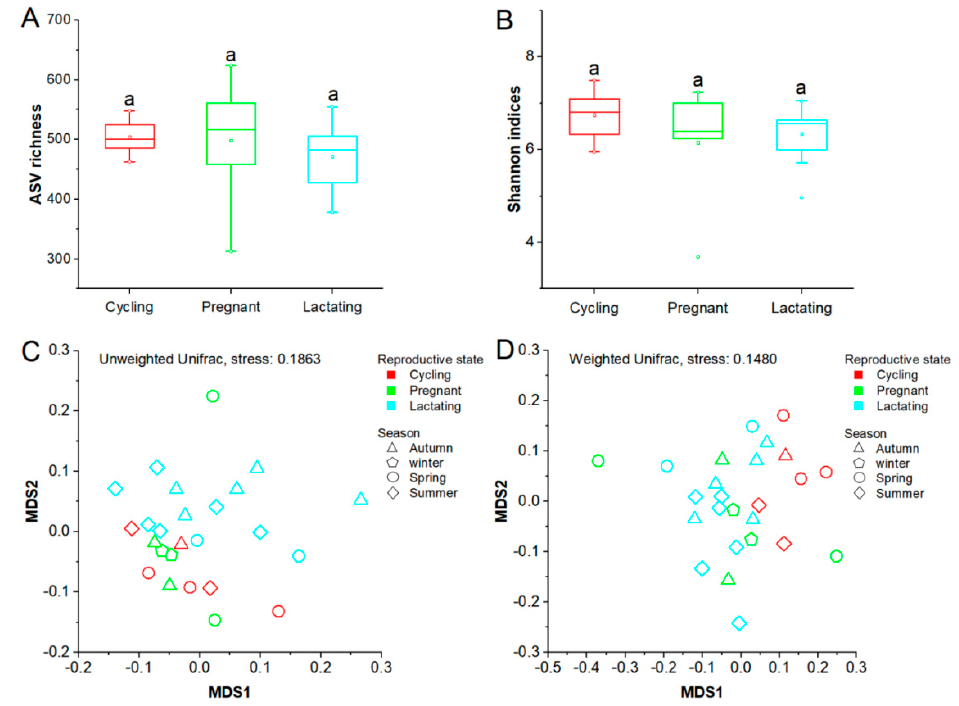
Figure 2. Differences in gut microbiome diversity of three reproductive states. ( A ): Comparison of ASV richness. ( B ): Comparison of Shannon diversity indexes. ( C ) and ( D ): Differentiation of gut microbiome structure. NMDS was used to show differentiation patterns of the three reproductive states. Adonis tests were performed on unweighted and weighted Unifrarc distance metrics. Significance level was 0.05.